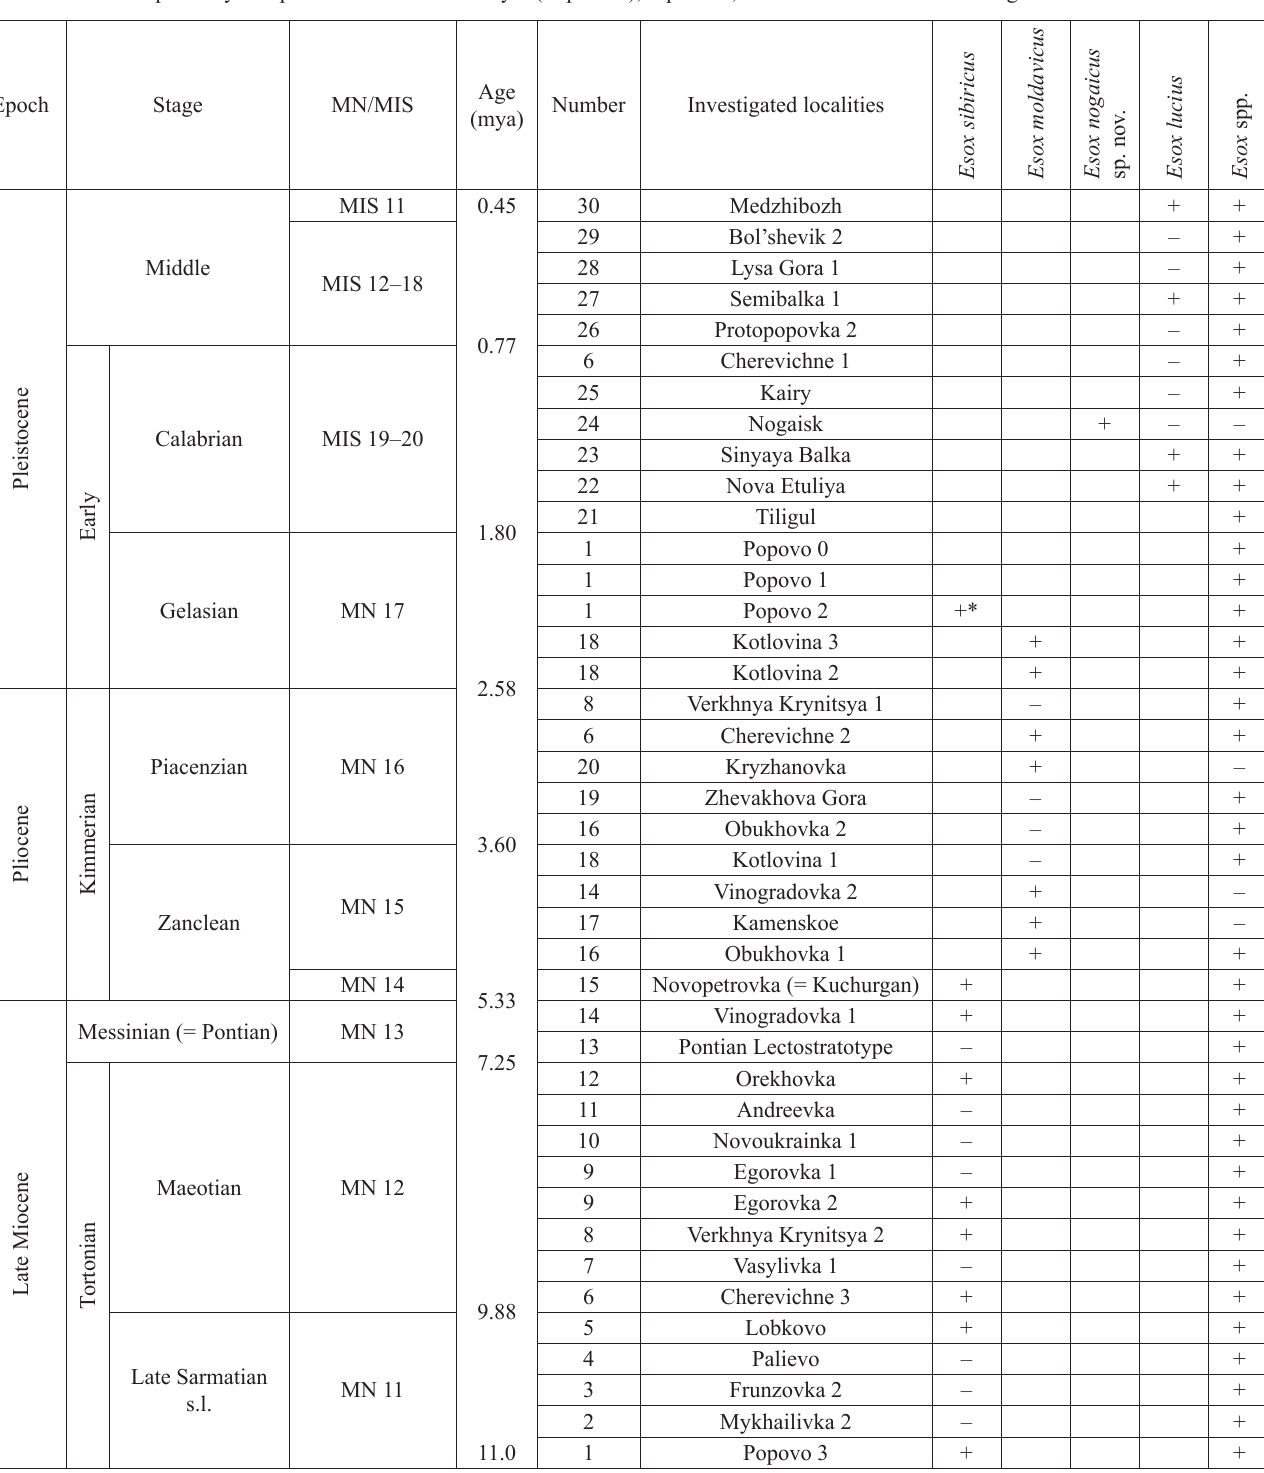
Table 1. Stratigraphic range of investigated localities with pike remains. MN, Mammal Neogene Zone; MIS, Marine Isotope Stage; * remains of Esox sibiricus were probably redeposited from the older layer (Popovo 3); + present; – absent. Numbers refer to Fig.